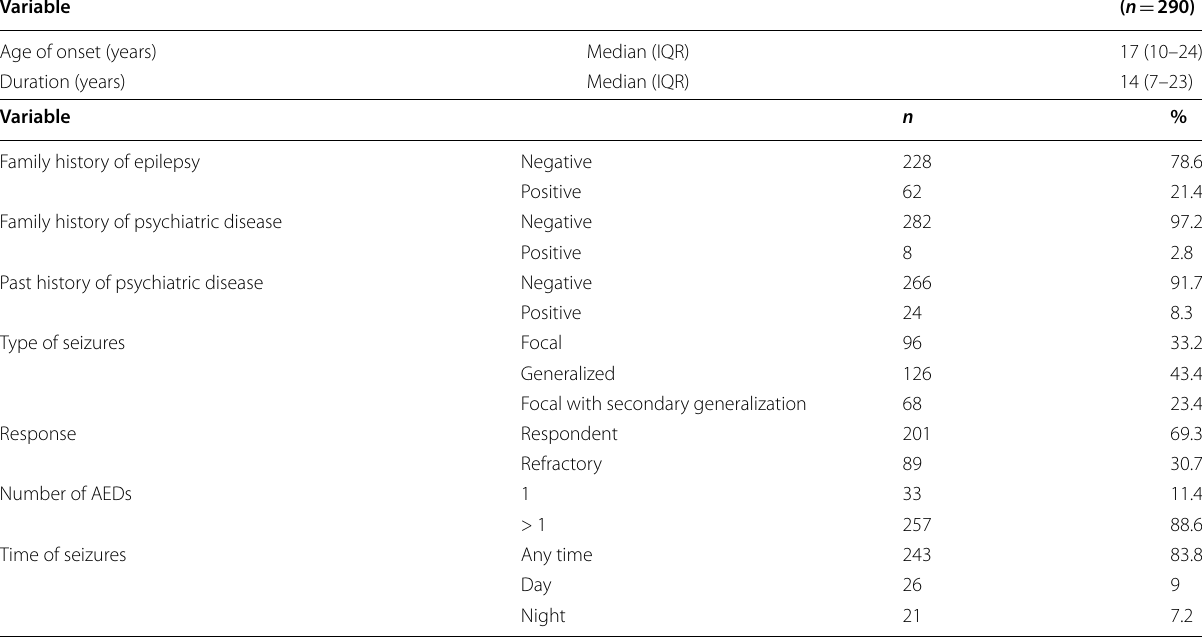
Table 2 Clinical data of epilepsy